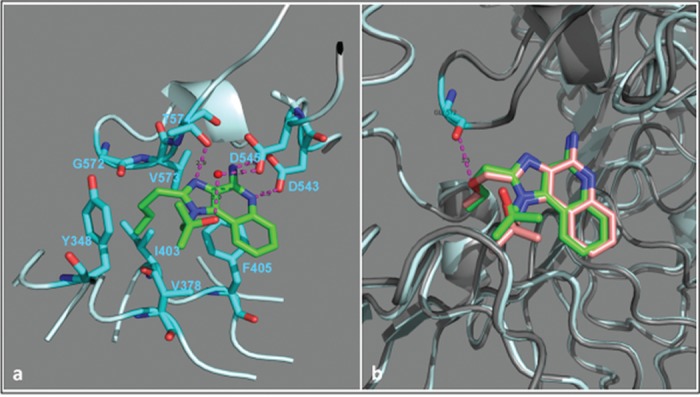
Crystal structure of Hybrid-2 and R848 with human TLR8.(A) The C-atoms of Hybrid-2 are shown in green, and the residues on TLR8 are shown in cyan. A water molecule involved in mediating the interaction between the hydroxyl on N1-substituent of Hybrid-2 and Asp545 residue is shown as a red sphere. The hydrogen bonds are represented as dashed lines in magenta, and the bond distances are marked in black. Overlay of crystal structures of Hybrid-2 and R848 with TLR8 is shown in (B). R848 is shown in light red and its TLR8 receptor shown in grey. The electrostatic repulsion between the backbone carbonyl of Gly572 residue and ether oxygen of the C2-ethoxymethyl substituent of R848 is shown in magenta.